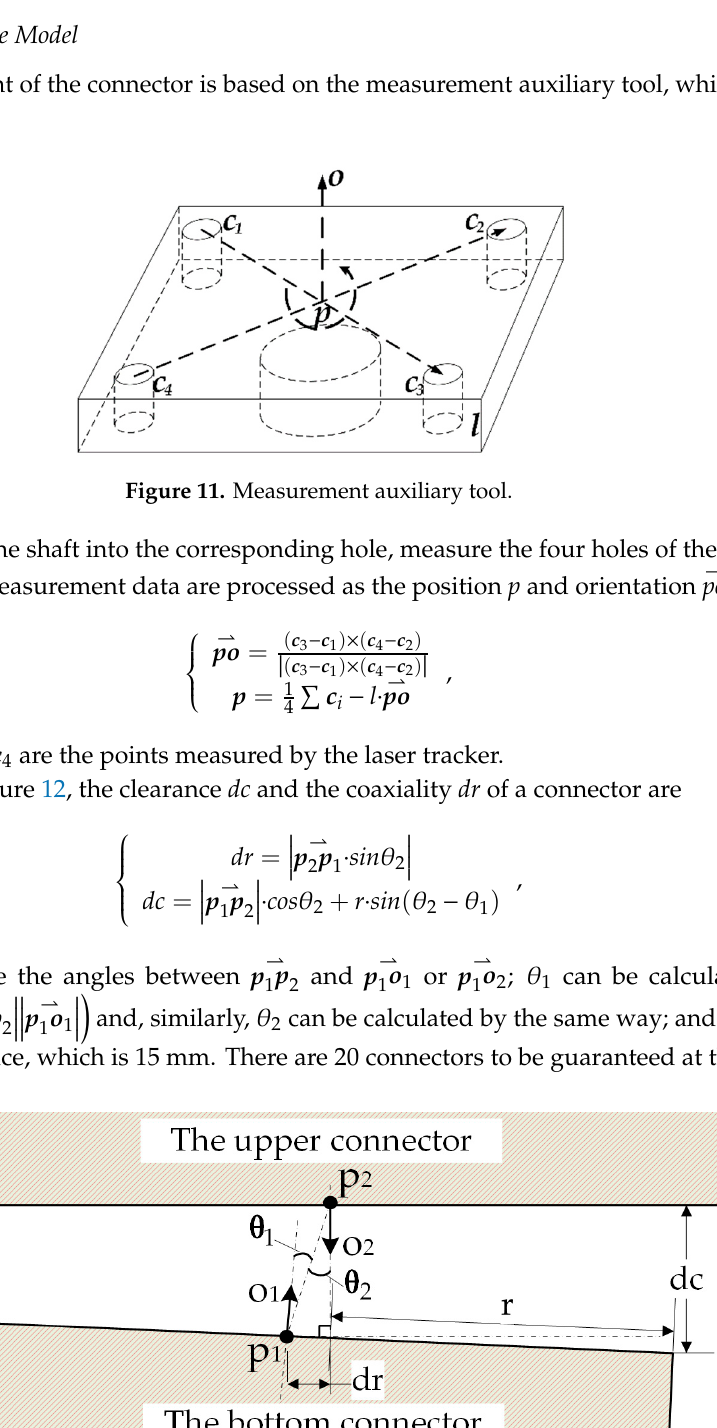
Figure 10. The comparison of the original and proposed assembly processes.